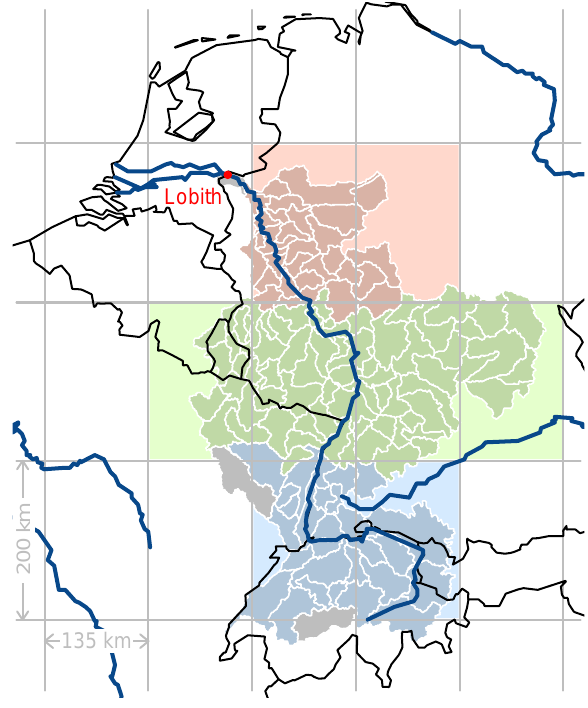
Fig. 1. The Rhine basin and ESSENCE grid. The basin is represented by 8 cells: 2 in the North Rhine (pink), 4 in the Central Rhine (green) and 2 in the Alpine Rhine (blue) region. CHR-OBS subbasins are outlined in white and shaded according to which region they are assigned for upscaling. Main waterways are traced in blue.